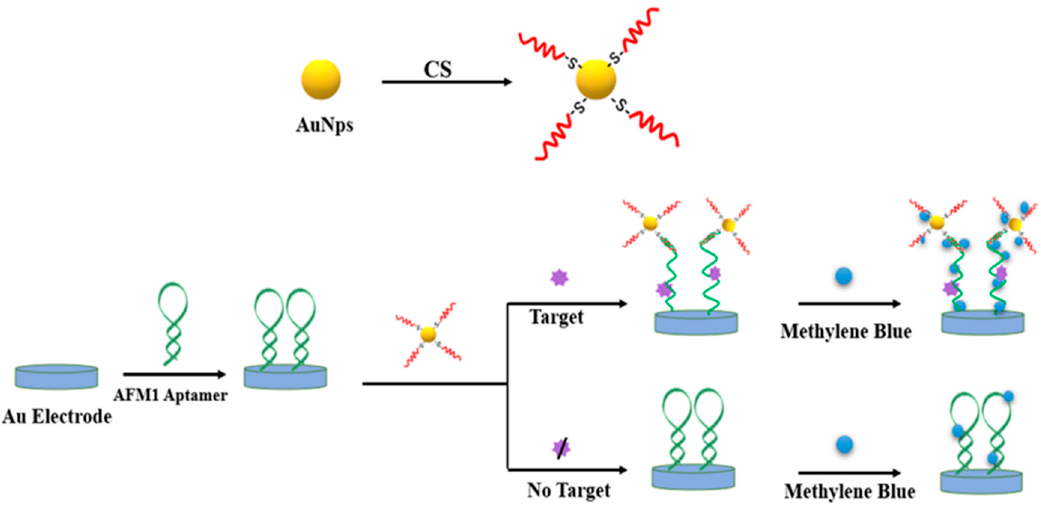
Figure 2. An electrochemical aptamer sensor for AFM1 detection.